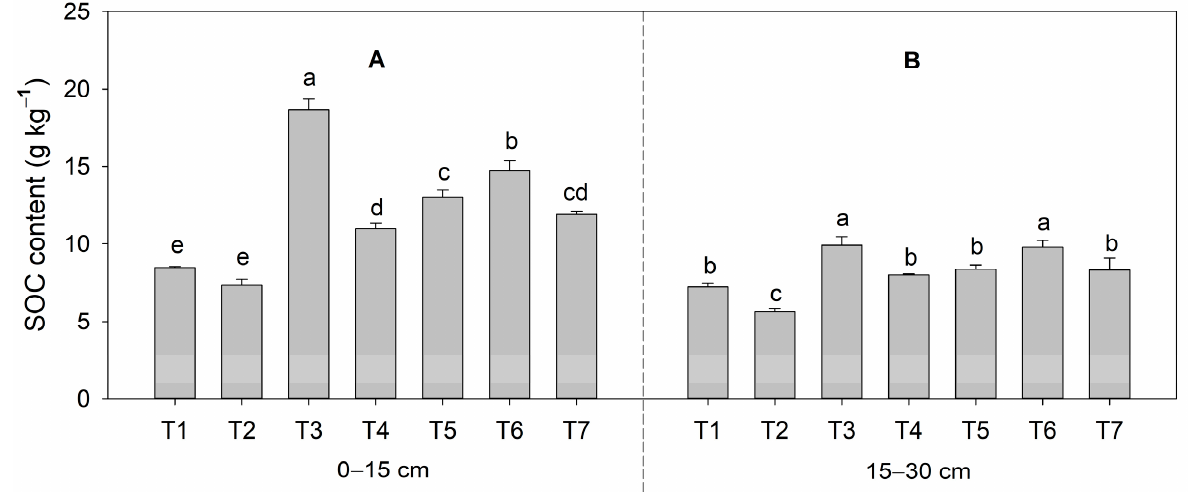
Figure 1. Soil organic carbon (SOC) content at 0–15 and 15–30 cm depths as affected by different treatments in 2020 after 12 years of annual fertilization. T1: N application by farmers (240 kg N ha − 1 ); T2: optimized N management (Nopt); T3: biochar + Nopt; T4: straw + Nopt; T5: manure + Nopt; T6: compost + Nopt; T7: biogas residue + Nopt. Lower-case letters indicate significant differences among treatments at a specific soil depth at p < 0.05 level. Capital letters indicate significant differences between the two soil depths at p < 0.05